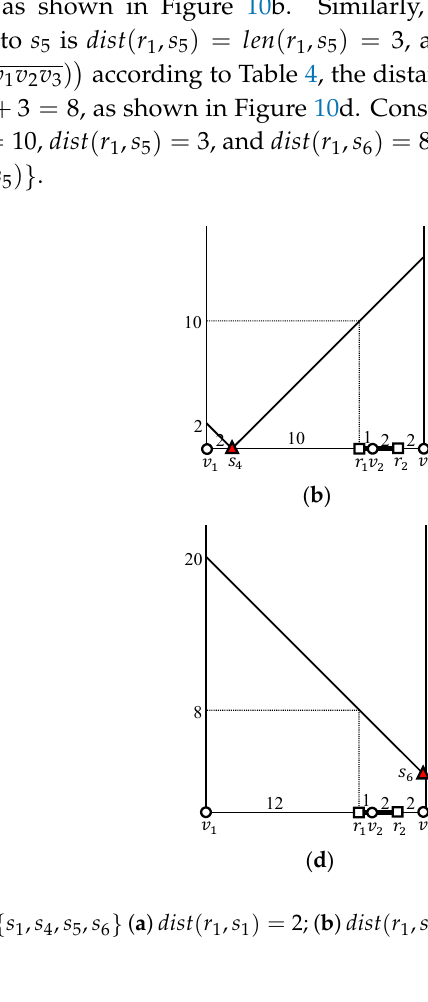
Table 4. Computation of (cid:1844) ⋈ (cid:3084) (cid:1845) using the EDISON algorithm.